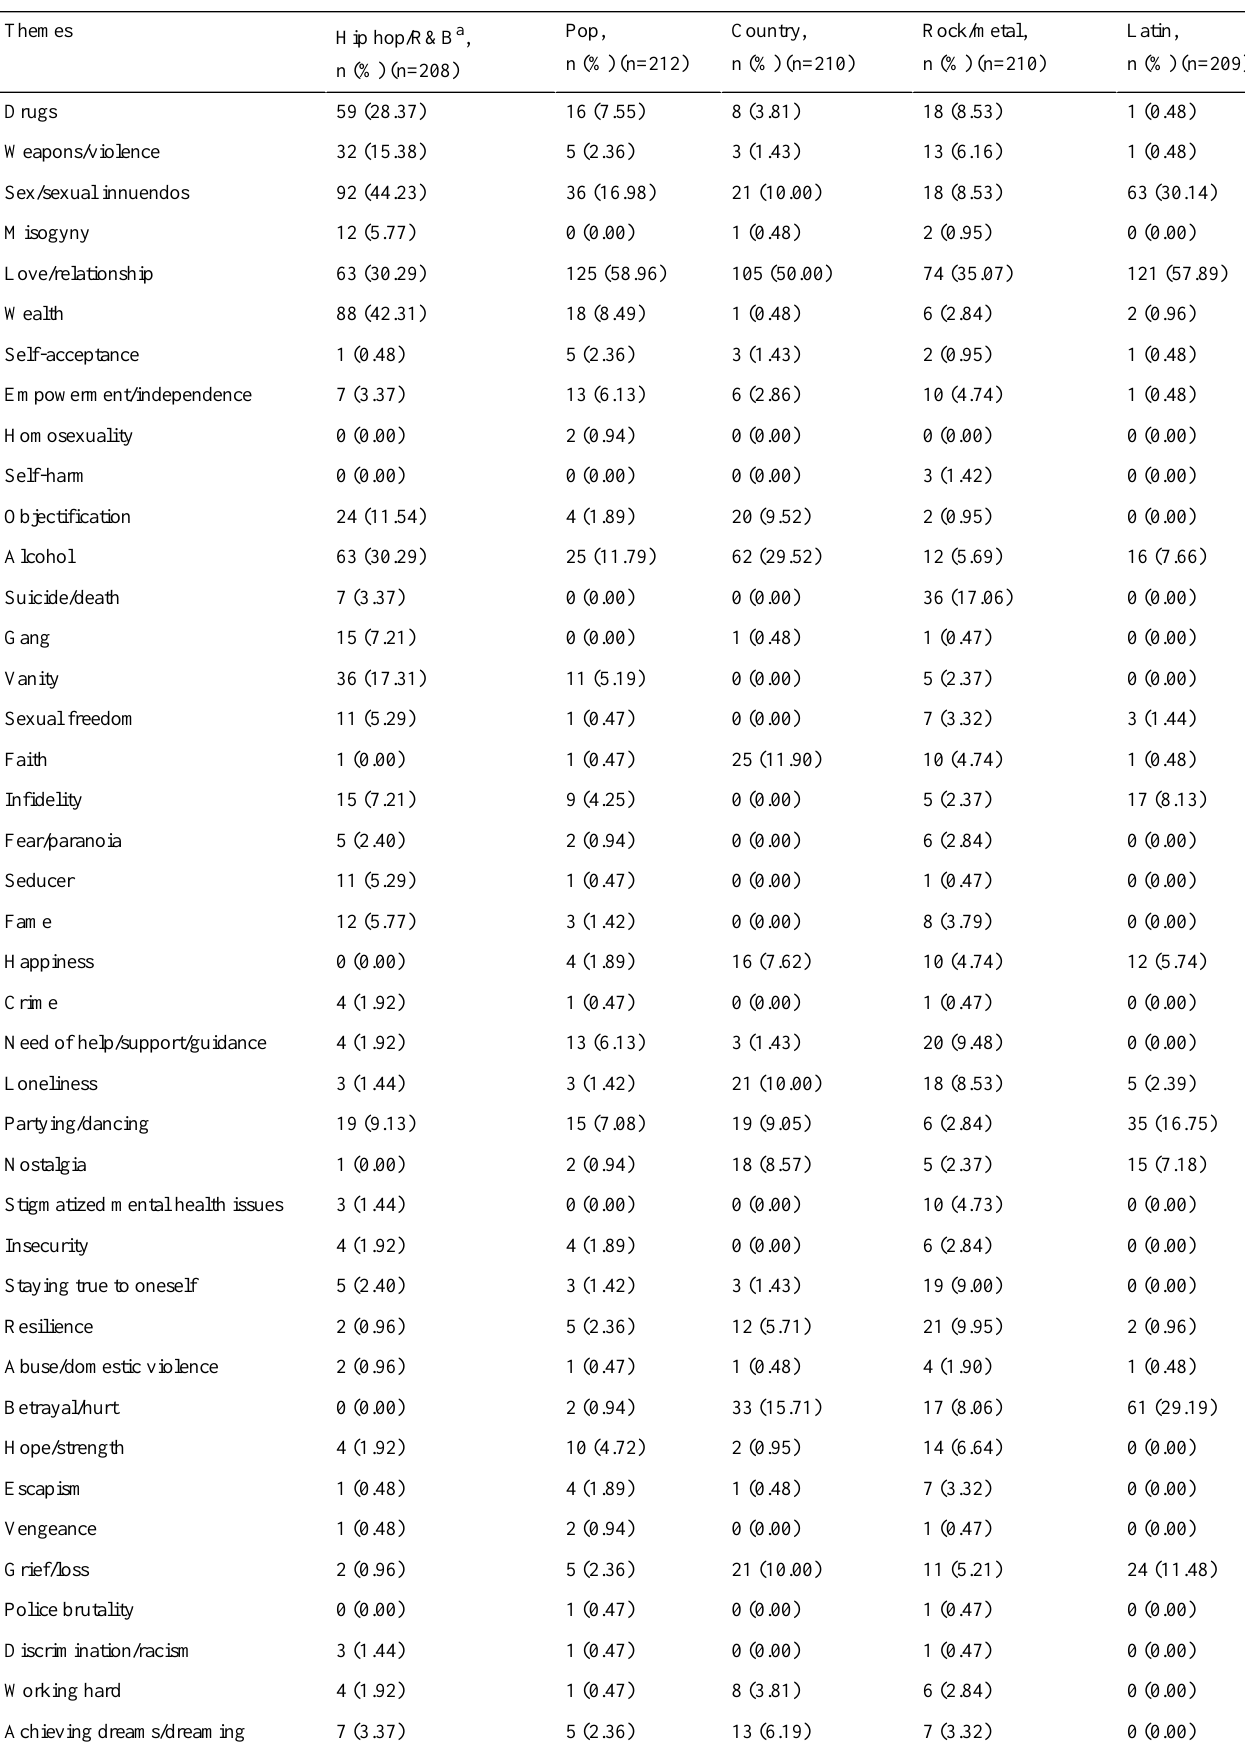
Table 4. Frequencies of themes within each genre.